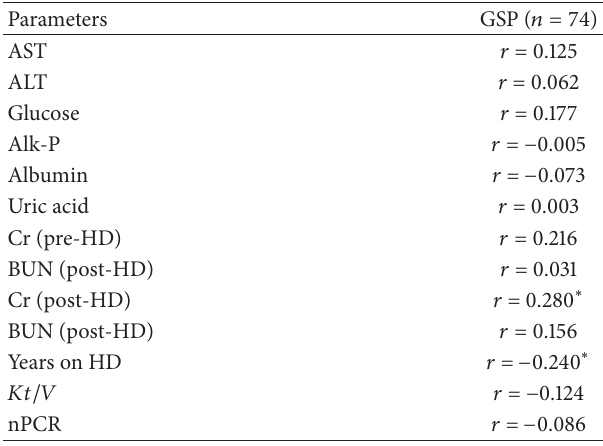
Table 1: The demographic data and biochemistry parameters of the patients in the study ( 𝑛 = 74 ).